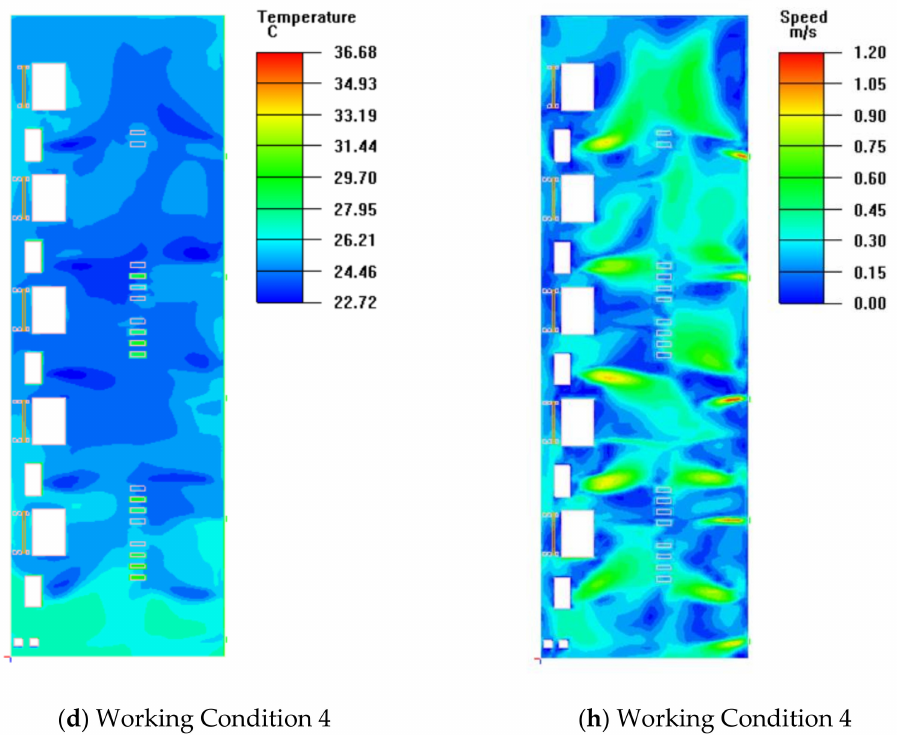
Figure 4. Temperature field and velocity field at a height of 1.6 under different working conditions